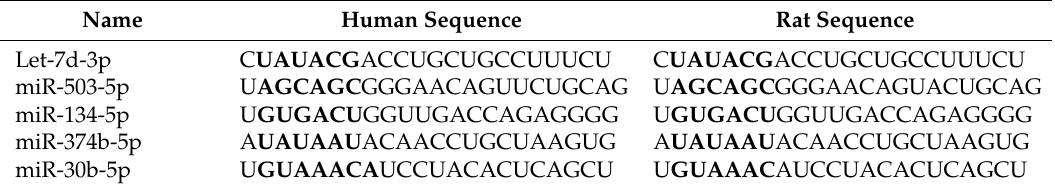
Table 1. Selected miRNA from clinical discovery data.